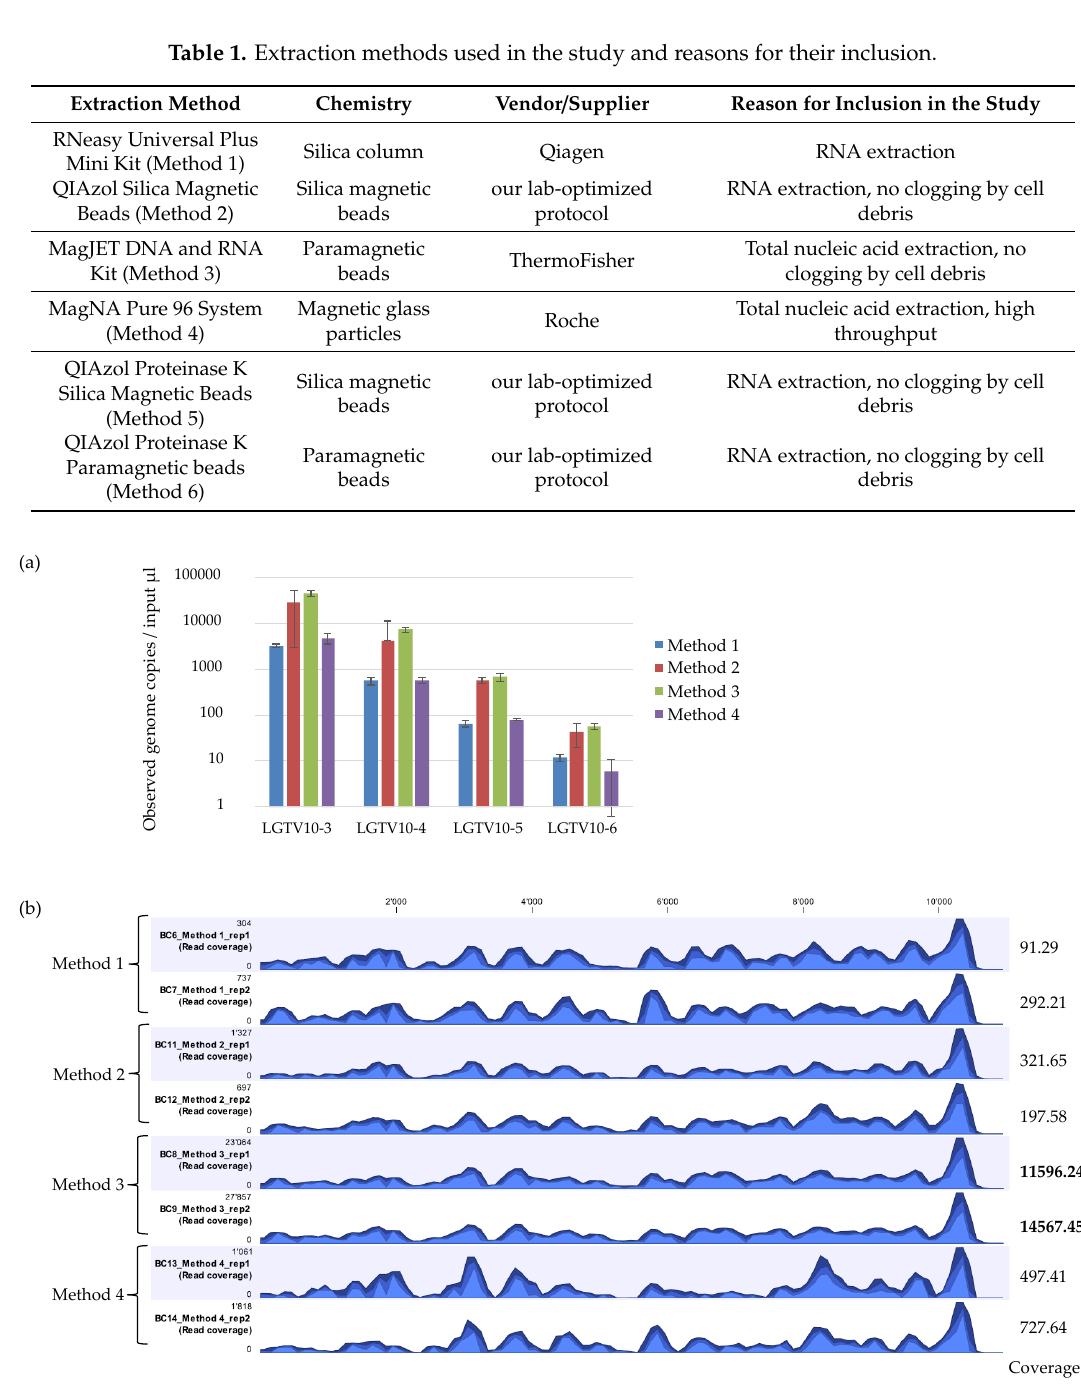
Figure 2. ( a ) Real time qPCR of observed genome copies recovered from Method 1, Method 2, Method 3, and Method 4. Reactions were performed in duplicates on duplicate extractions from LGTV serial dilutions at 10 − 3 , 10 − 4 , 10 − 5 , and 10 − 6 spiked into tick homogenates. Error bars represent means ± SD. N = 4. ( b ) Coverage track profiles of LGTV mapped reads to the reference genome (TP21 EU790644) recovered using Method 1, 2, 3, and 4. The y-axis on the left within the coverage tracks indicated read coverage. Average coverage values are indicated for each sample on the right. The three blue shades show the minimum (light blue), mean (medium blue), and maximum (dark blue) observed values in a given